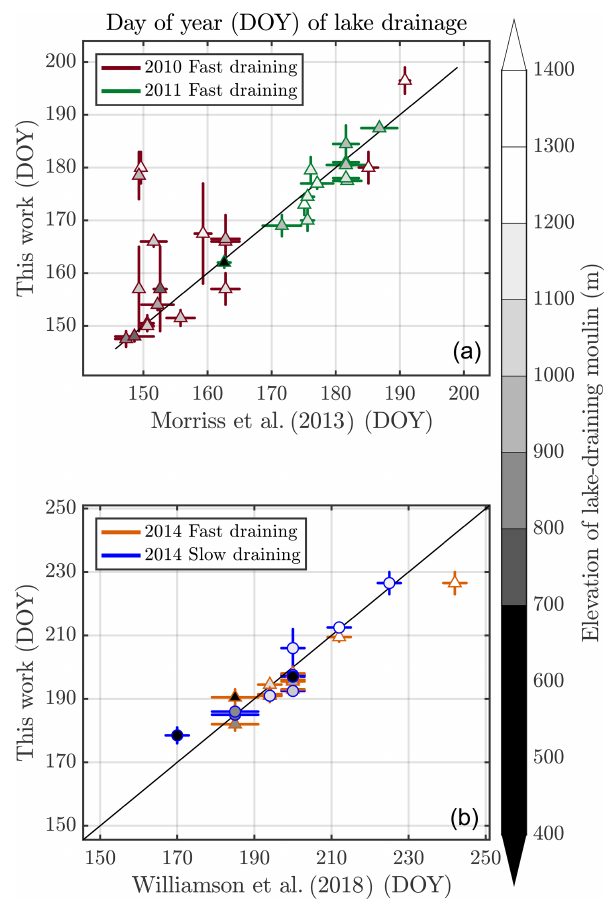
Figure 3. Comparison of lake drainage dates in this work to pre- vious work, in the years that we have overlap. Elevations of each moulin (Bamber et al., 2013) are shown by the gray tone, and marker shape indicates lake drainage type: triangles show fast- draining lakes, and circles show slow-draining lakes. (a) Compar- ison to Morriss et al. (2013) over the years 2010–2011. Drainage dates of 22 out of 33 lakes (67%) agree to within uncertainties. (b) Comparison to Williamson et al. (2018b) over 2014. Drainage dates of 16 out of 21 (76%) lakes agree to within